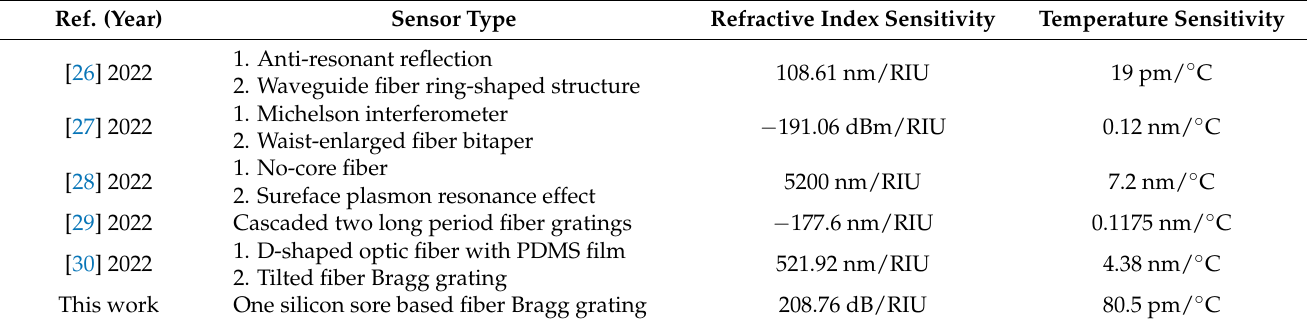
Table 1. Comparison of simultaneous refractive index and temperature-sensing performance study with existing